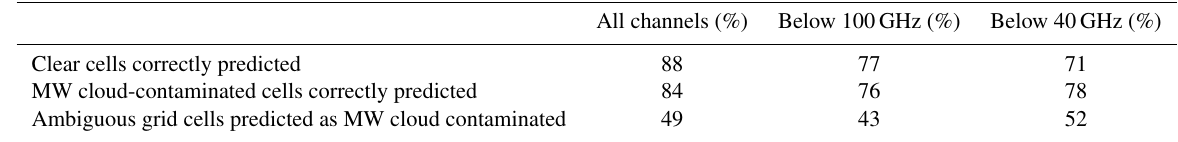
cloud contaminated by the new classification (close to 50 % regardless of the frequency